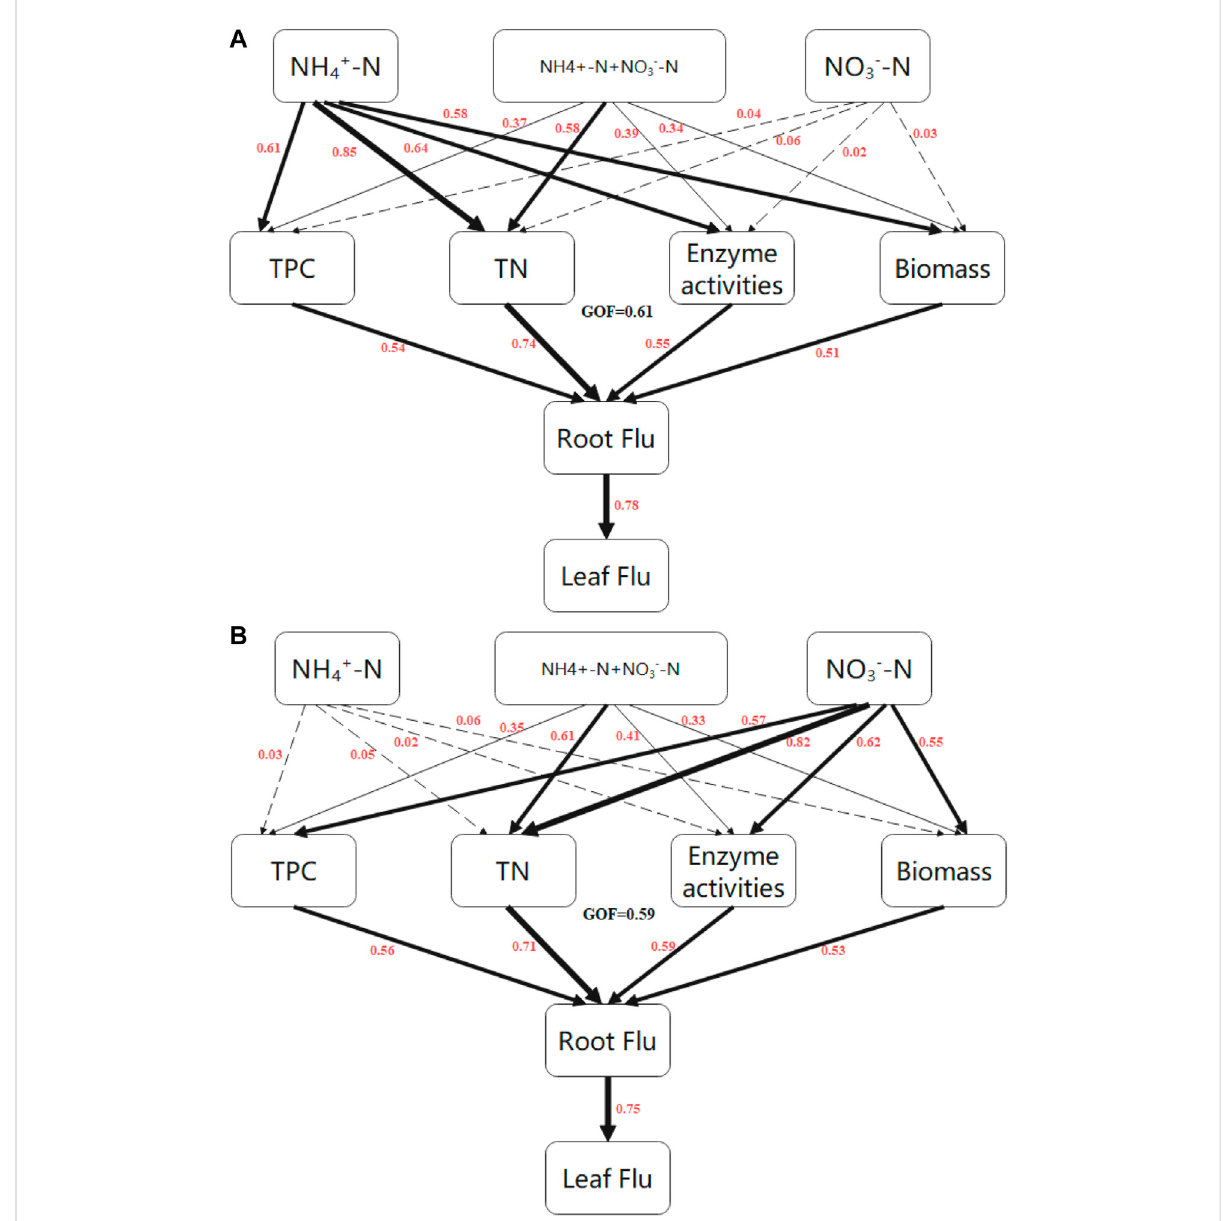
FIGURE 4 Directed graph of the partial least squares path model (PLS-PM) of rice (A) and wheat (B) . Each box represents an observed variable (i.e.,measured)orlatentvariable(i.e.,constructs).PLS-PMdescribingtherelationshipsbetweenNforms,TPC,TN,enzymeactivities,biomass,andFlu concentration. Flu: Fluoranthene concentration; T1\ Total nitrogen; TPC: Total protein concentration; Enzyme activities: Peroxidase, superoxide dismutase and catalase. Path coef fi c ients are calculated after 1000 bootstraps and re fl ected in the width of the arrow, with hick indicating positive effects. Dashed arrows show that coef fi cients did not differ signi fi cantly from 0 (P > 0.05). The model is assessed using the Goodness of Fit(GoF) statistic, and the GoF value was OA (A) and 0.59 (B) ,